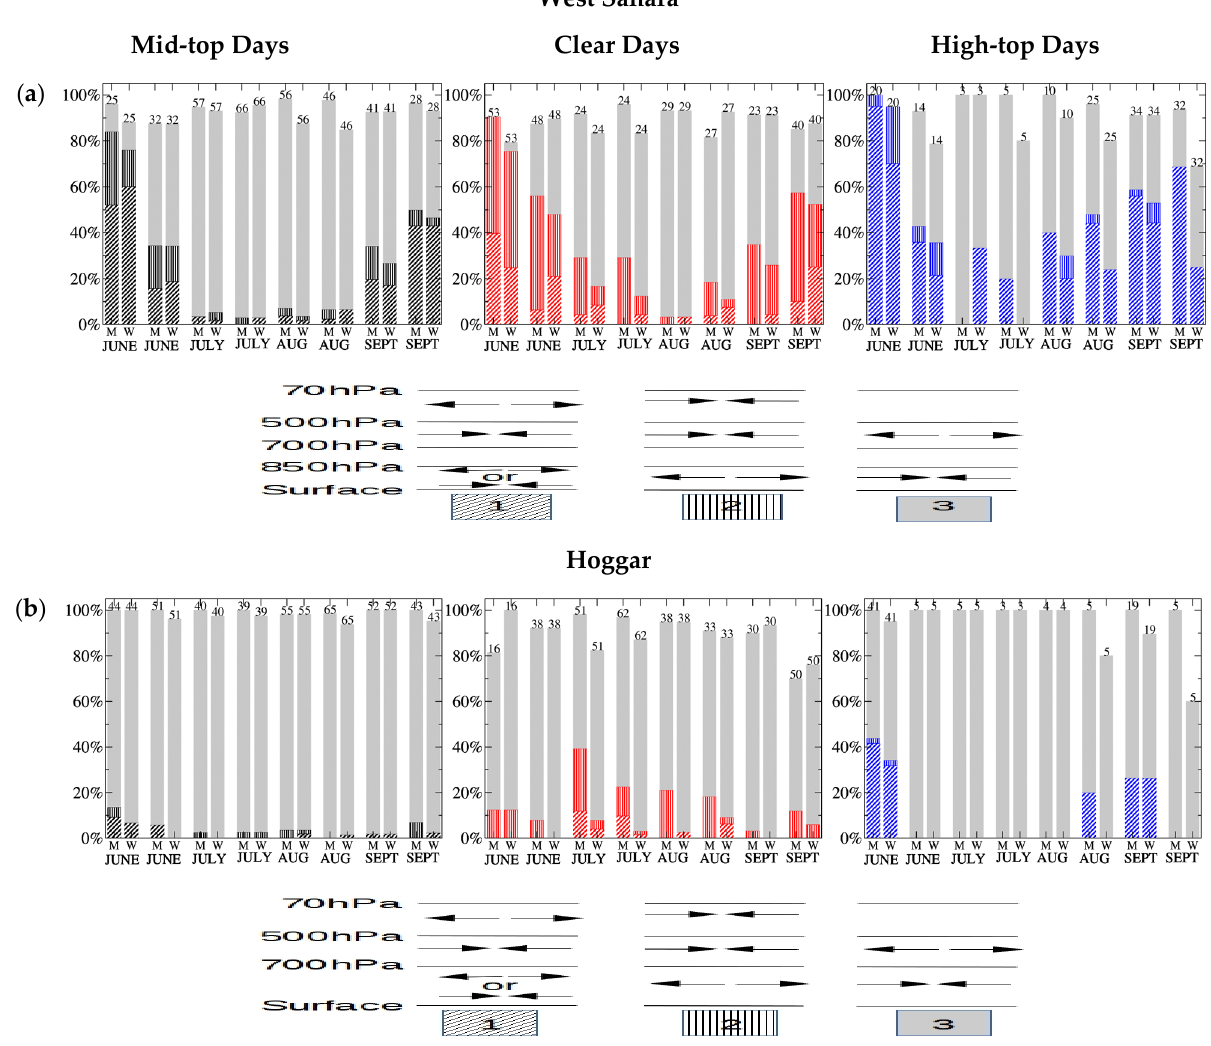
Figure 15. ( a ) For mid-top days (left), clear days (center) and high-top days (right), for the mass M and for the water vapor W, occurrence frequency distribution of the convergence profiles in the 3 type classification estimated over 15-day periods over West-Sahara; the frequency of profiles not classified indicated by the gap between the top of the bar and 100%; at the top of the bars, the number of mid-top day, clear day and high-top day. ( b ) same as ( a ) but for the Hoggar.